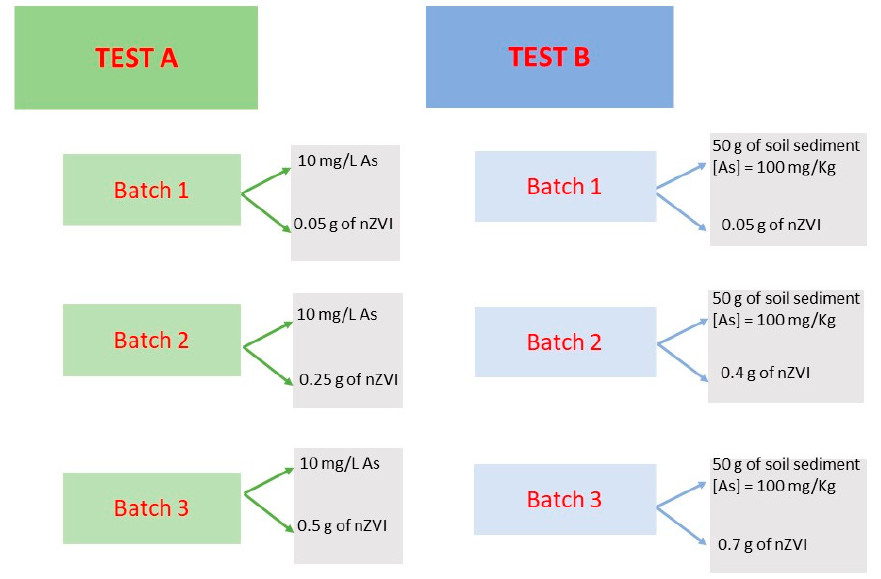
Figure 2. Scheme of experiments .